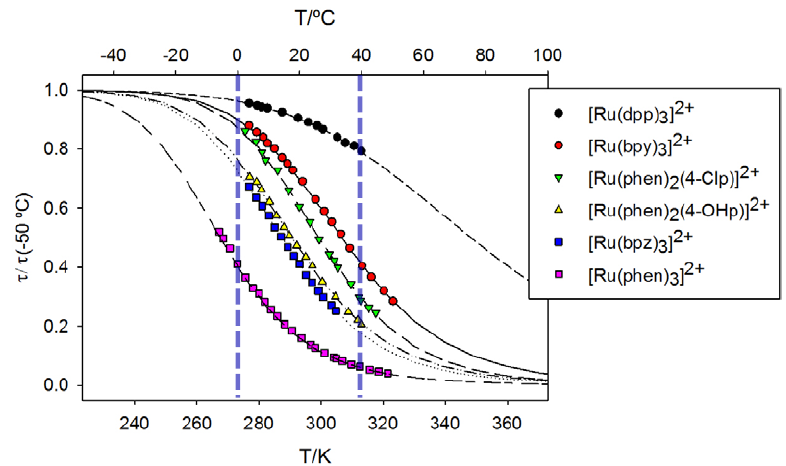
Figure 3. Luminescence lifetimes (normalized at 223 K) as a function of temperature of the Ru(II) complexes in deoxygenated propylene carbonate solution (PC-11 N aq HCl 10:1 v / v for the hydroxylated complex). The black lines stand for the best computer fit (Sigma Plot 11.0) of the experimental data to Equation (1), assuming contribution of only one thermally activated pathway. From top to bottom: (– –) [Ru(dpp) 3 ] 2+ ; (– –) [Ru(bpy) 3 ] 2+ ; (– –) [Ru(phen) 2 (4-Clp)] 2+ ; (– –) [Ru(phen) 2 (4-OHp)] 2+ ; (– –) [Ru(bpz) 3 ] 2+ ; (– –) [Ru(phen) 3 ] 2+ . The blue vertical dashed lines highlight the range 0–40 °C range of interest for the sought applications.